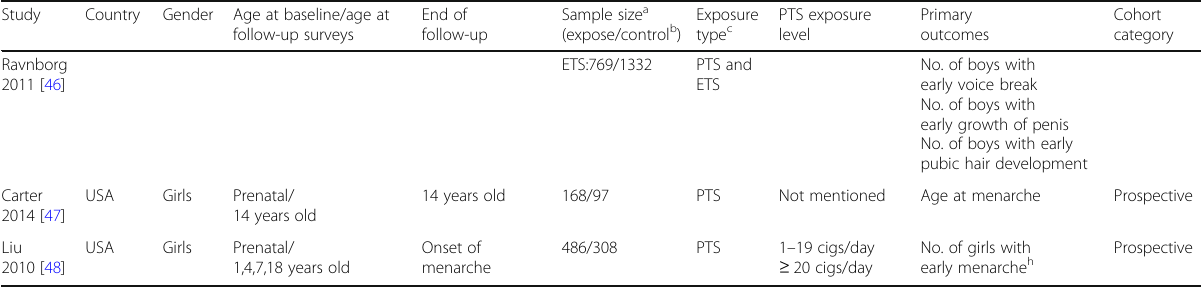
Table 1 Characteristics of Included Studies (Continued)